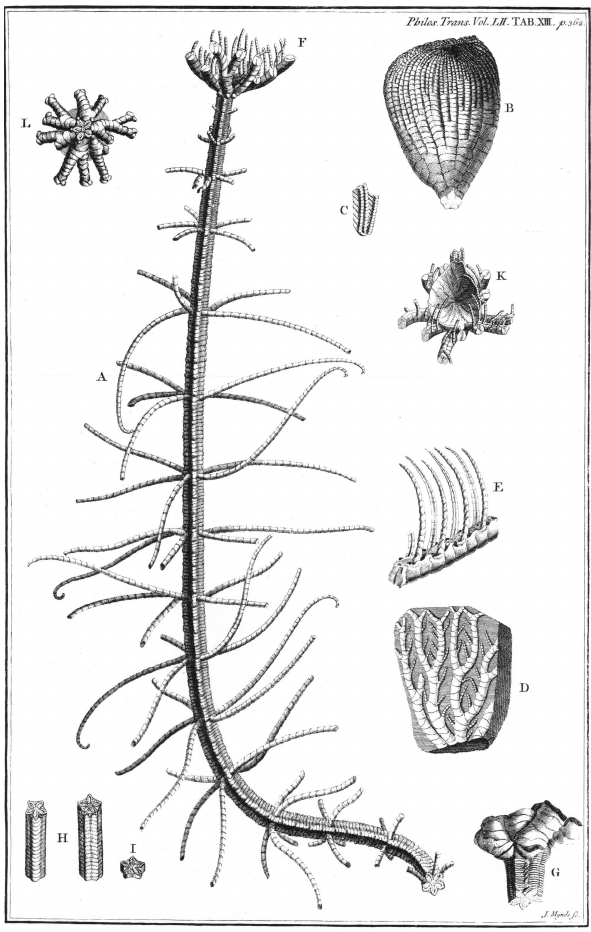
Figure 3. Cenocrinus asterius (Linné, 1767) (from Ellis, 1762, pl. 13; as “Encrinus” from Barbados). This specimen was the second modern stalked crinoid that was described. Also figured are fos- sil forms: B and C are from the Early Jurassic (Sinemurian) of Pyrton-passage. The site has furnished Isocrinus (Chladocrinus) tuberculatus (Miller, 1821) but the drawings are too stylized for proper assignment. D is an indeterminable crinoid copied from Ros- inus (1719). G shows the upper part of the stalk and the base of the crown of Eocomatula interbrachiatus (Blake, 1876) from the Early Jurassic (Pliensbachian) of Marston